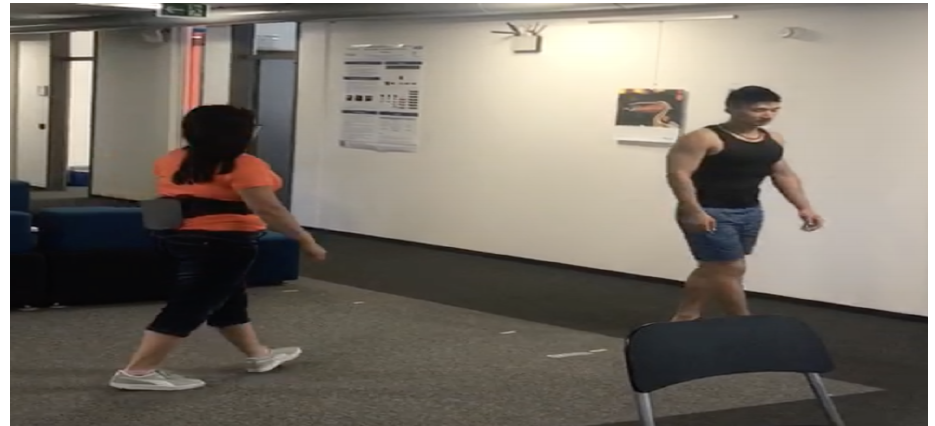
Figure 15. Two volunteers with the prototype on body performing randomly walking-by events without any instructions at an empty area with size of 5 × 5 m.